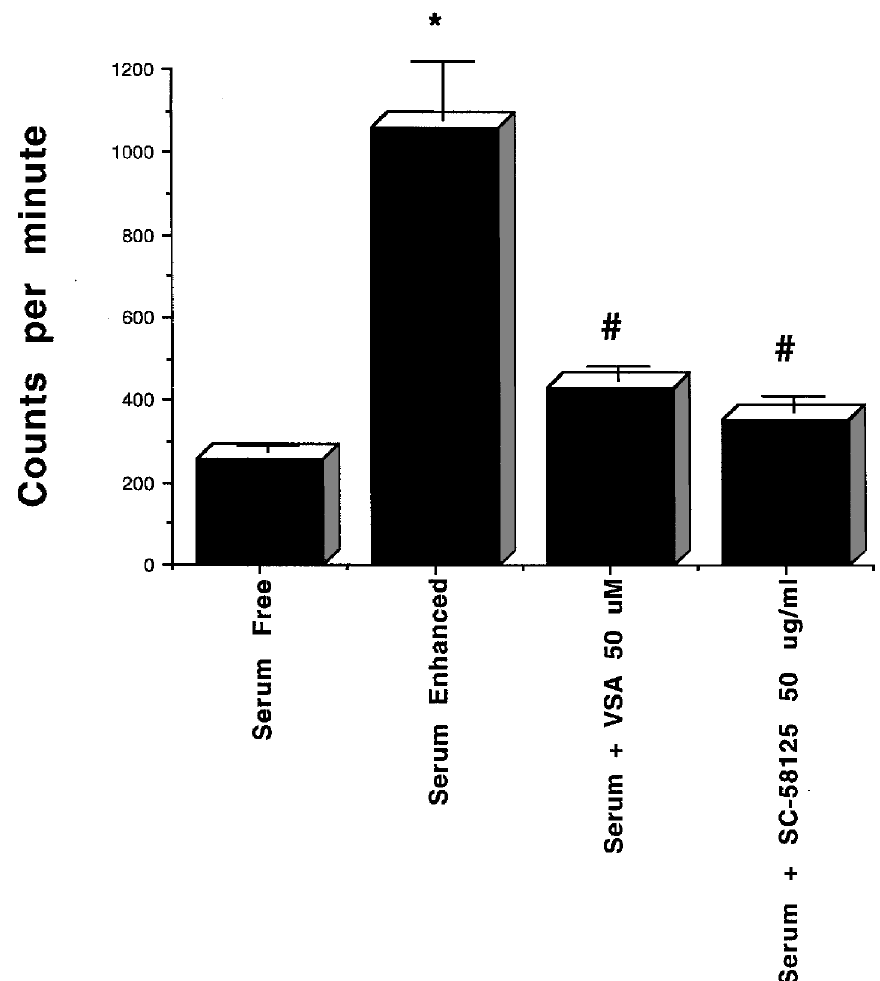
FIG. 4. The effect of specific COX inhibitors on serum enhanced 3 H thymidine incorporation by HISM cells. The * indicates that serum significantly increased 3 H thymidine incorporation compared to serum free cells. The # indicates that the COX inhibitor significantly decreased 3 H thymidine incorporation compared to serum enhanced